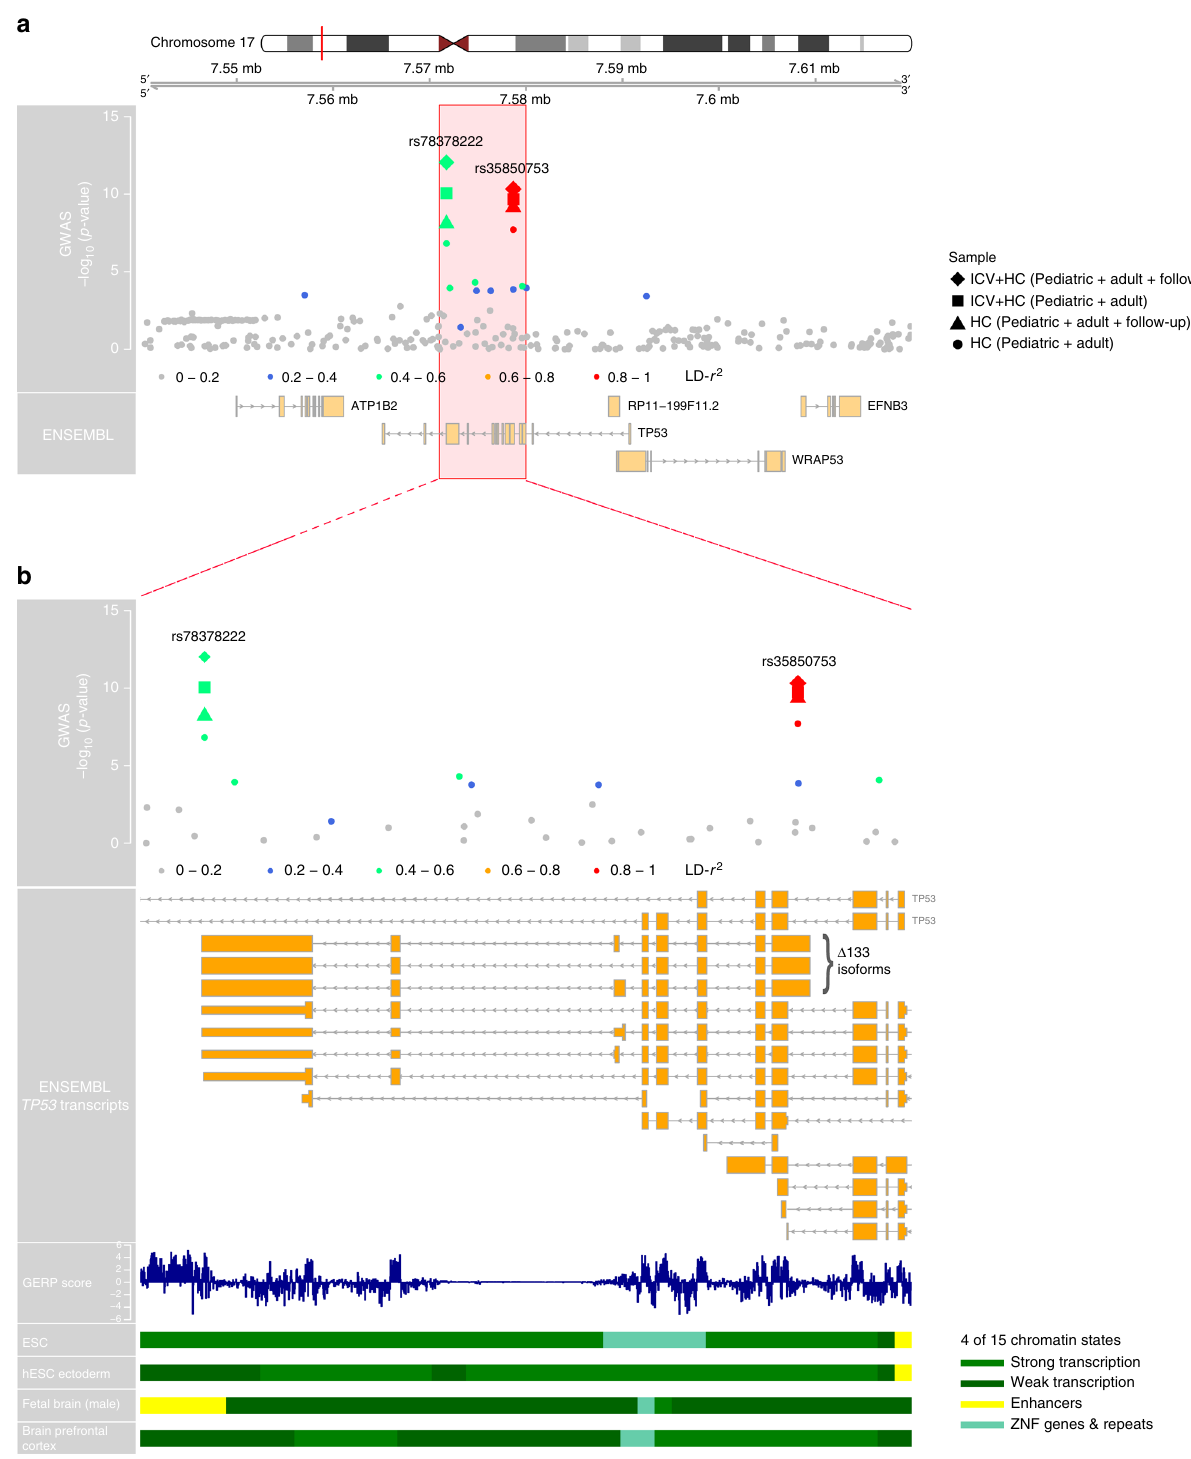
Fig. 3 Regional association plot at 17p13.1 associated with fi nal head circumference (HC) and fi nal cranial dimension. a Depicts a 800Mb window and b a zoomed view of genetic association signals and functional annotations near TP53 . Within each plot, in the fi rst panel SNPs are plotted with their − log 10 p value as a function of the genomic position (b37). This panel shows the statistical evidence for association based on HC (Pediatric + adult) and combined ICV + HC (Pediatric + adult) meta-analyses, including HC follow-up studies. SNPs are colored according to their correlation with the HC lead signal (rs35850753, pairwise LD- r 2 -values). The second panel represents the gene region (ENSEMBL GRCh37). The third panel in ( b ) presents the Genomic Evolutionary Rate Pro fi ling (GERP ++ ) score of mammalian alignments. The last four panels in ( b ) show 4 of 15 core chromatin states, present in the zoomed view, from the Roadmap Epigenomics Consortium including Embryonic Stem Cells (ESC), hESC Derived CD56 + Ectoderm Cultured Cells, Fetal Brain (Male) and Brain Dorsolateral Prefrontal Cortex respectively (see legend for color